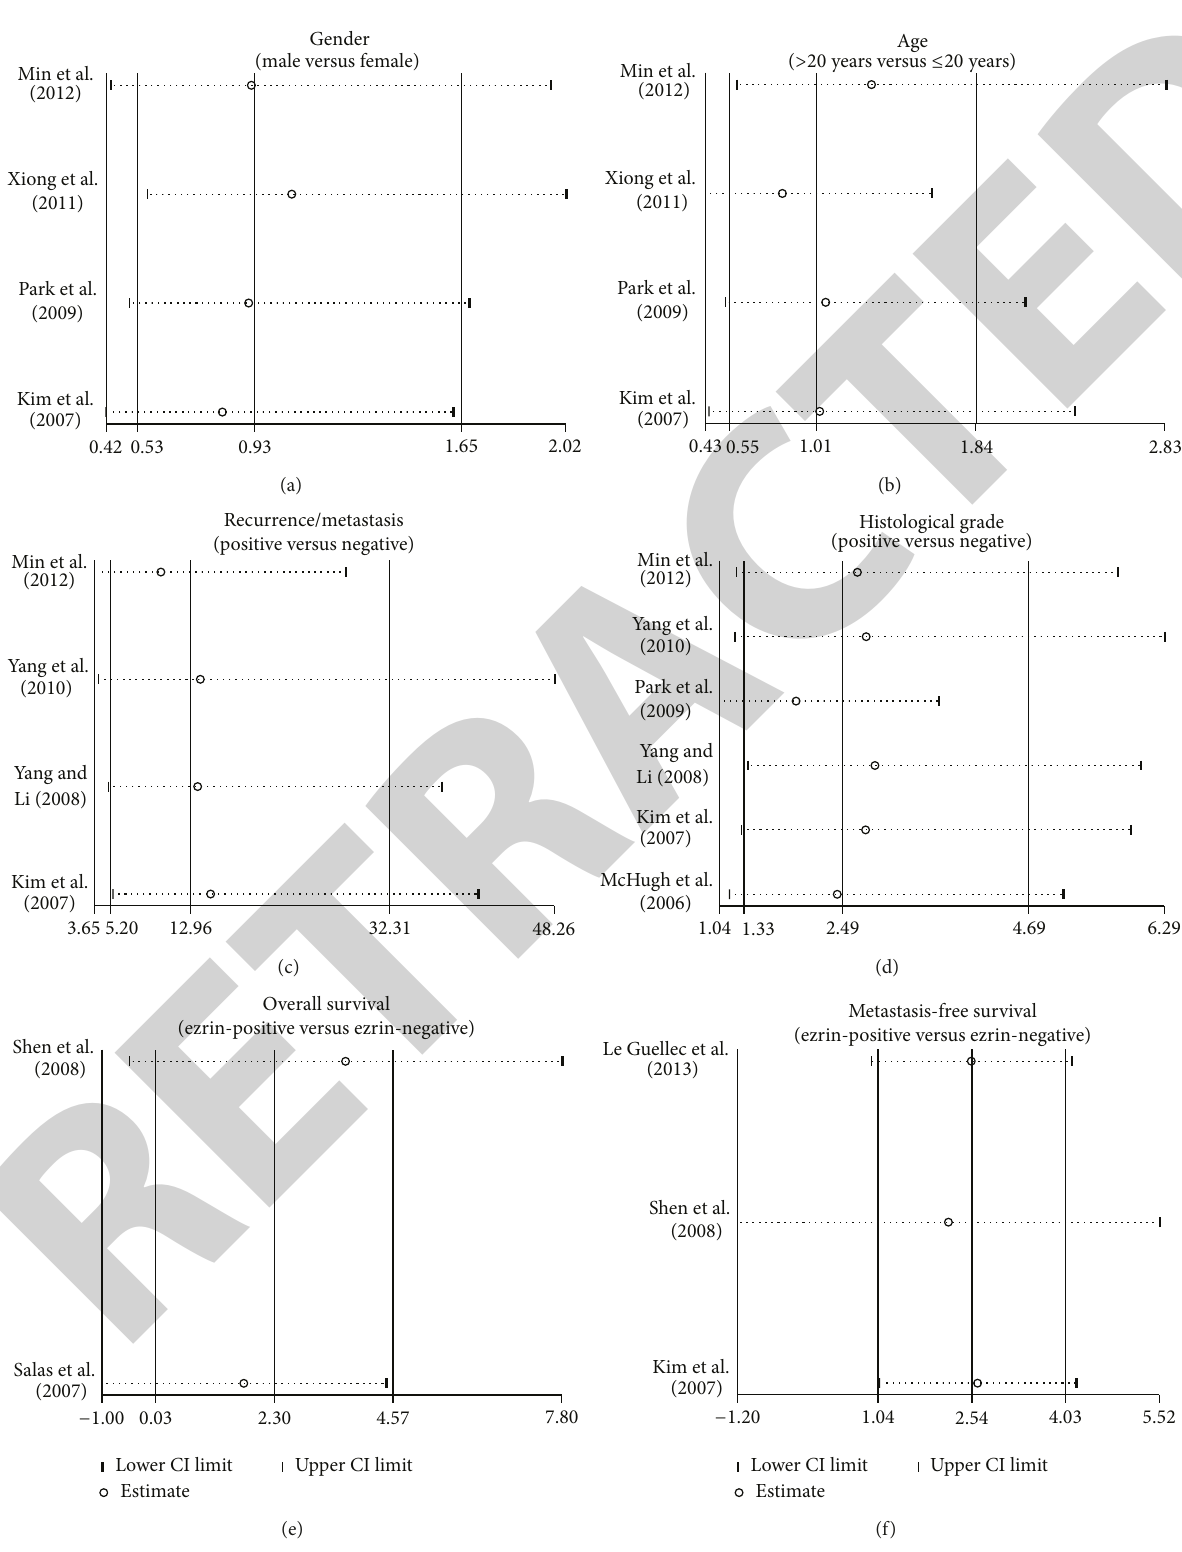
Figure 4: Sensitivity analysis of the summary odds ratio coefficients on the correlations of ezrin expression with pathological characteristics and prognosis of osteosarcoma under the allele and dominant